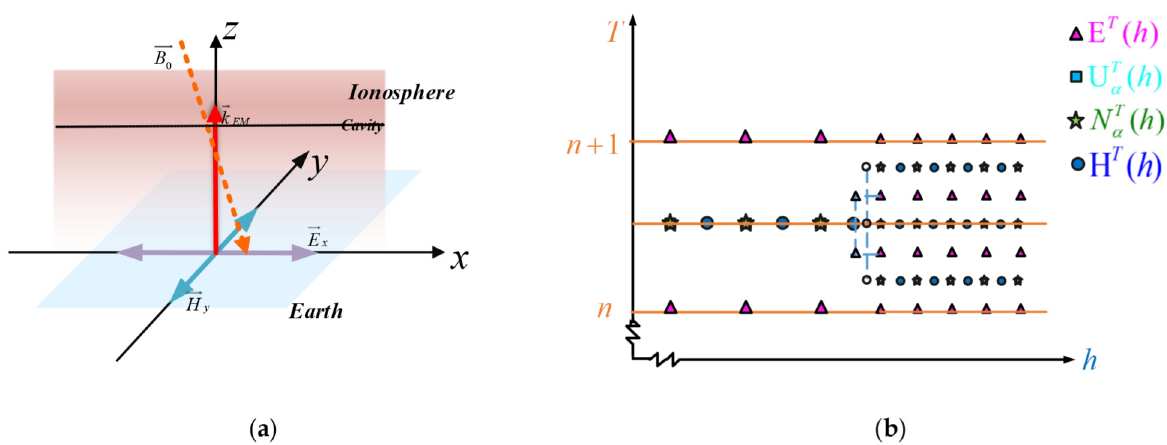
Figure 1. ( a ) Schematic showing the simulation model of the EM wave propagation in the ionosphere: B 0 is the geomagnetic field; k EM is the propagation direction of the injected EM wave; E x and H y are the initial polarized direction of the electric field and magnetic field of the injected EM wave, respectively; the dotted line represents the approximate location of the cavity. ( b ) Spatial–temporal dispersion scheme of the physical parameters, with the positions of field nodes